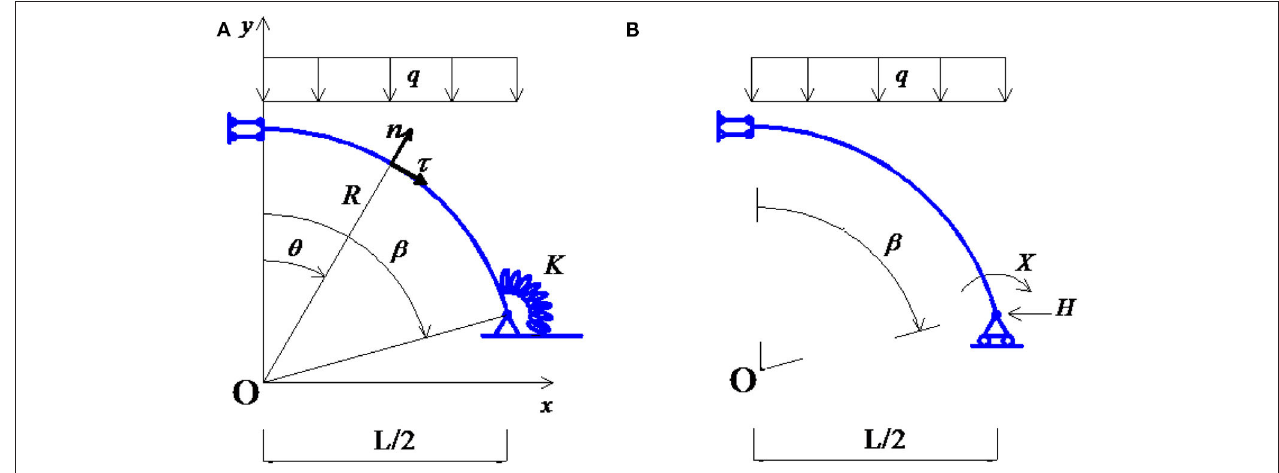
FIGURE 1 | (A) Static scheme. (B) Primary structure in force